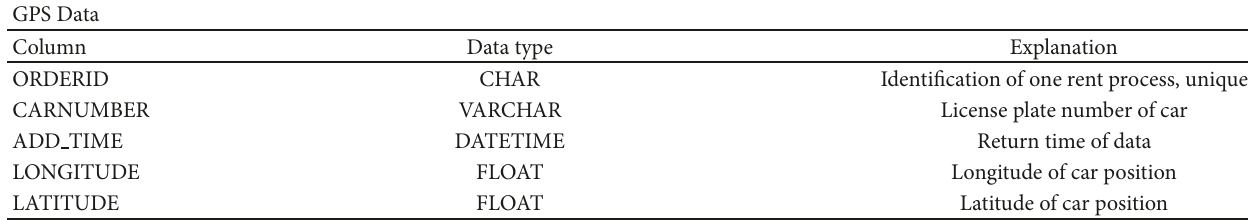
Table 2: Data frame of GPS data.